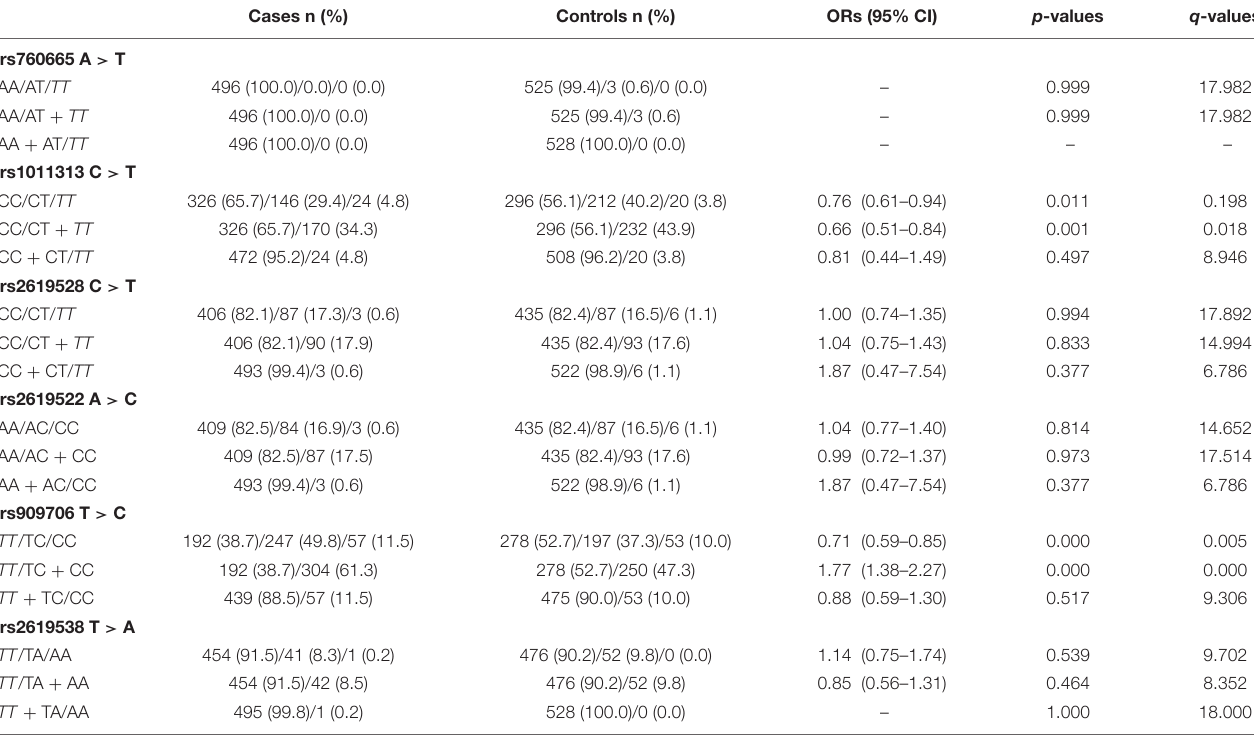
TABLE 3 | Inheritance models of the SRR SNPs in cohorts 1 + 2. Cases n (%)